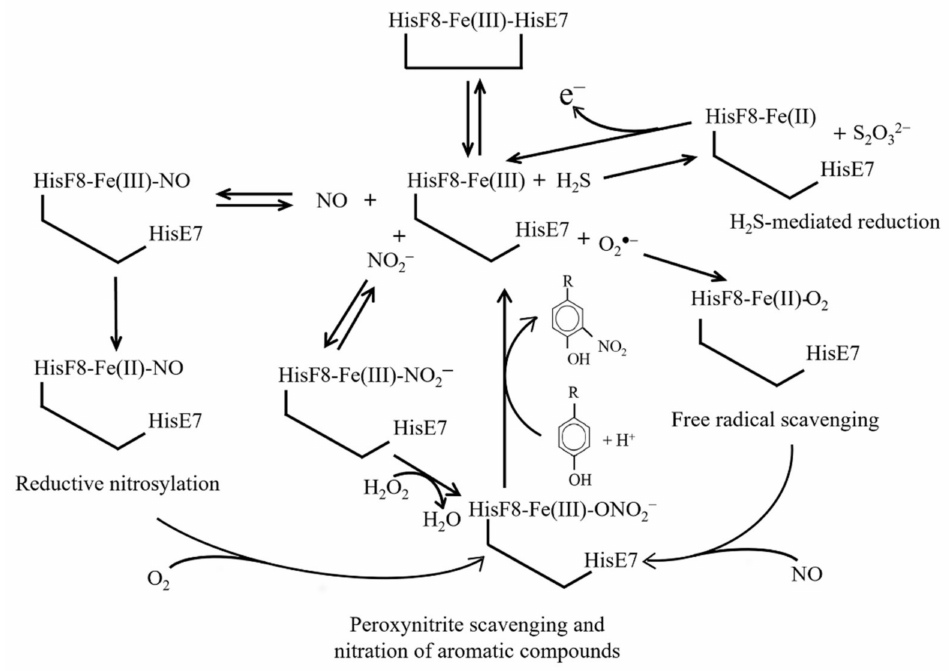
Figure 4. (Pseudo-)enzymatic properties of Ngb(III). The Ngb unreactive hexacoordinated HisF8- Fe(III)-HisE7 species and the reactive pentacoordinated HisF8-Fe(III) conformation are